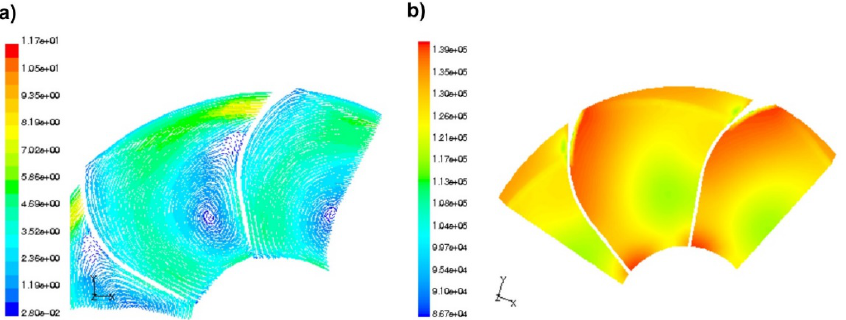
Figure 23. The field of: ( a ) velocity [m/s]; ( b ) static pressure [Pa] in the channels of the guide vanes for the radius R = 30 mm.